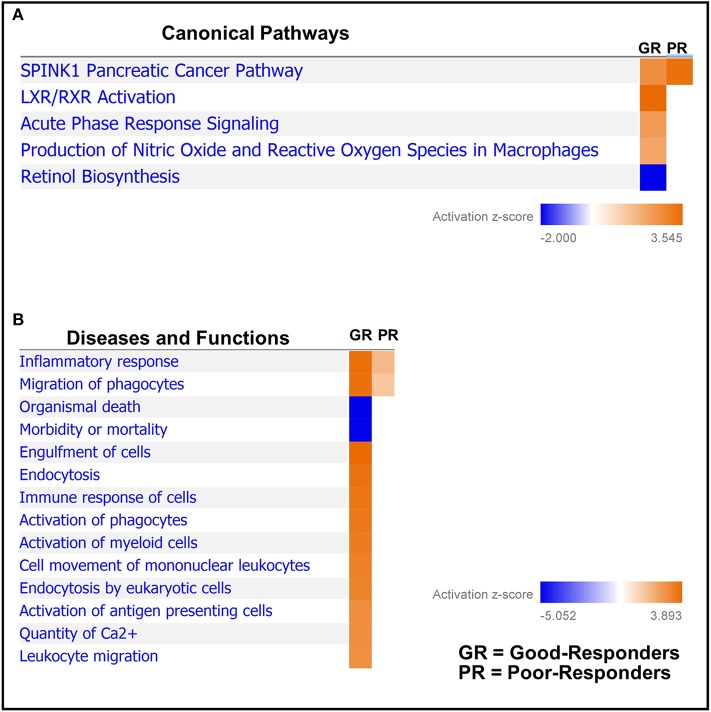
Comparative pathways and associated disease/functions between good- and poor-NAC Responders. Ingenuity pathway analysis was performed to identify (A) canonical pathways; and (B) associated disease/function affected in the tumor tissue of good- and poor-NAC responding PDAC patients, compared to adjacent normal pancreas.